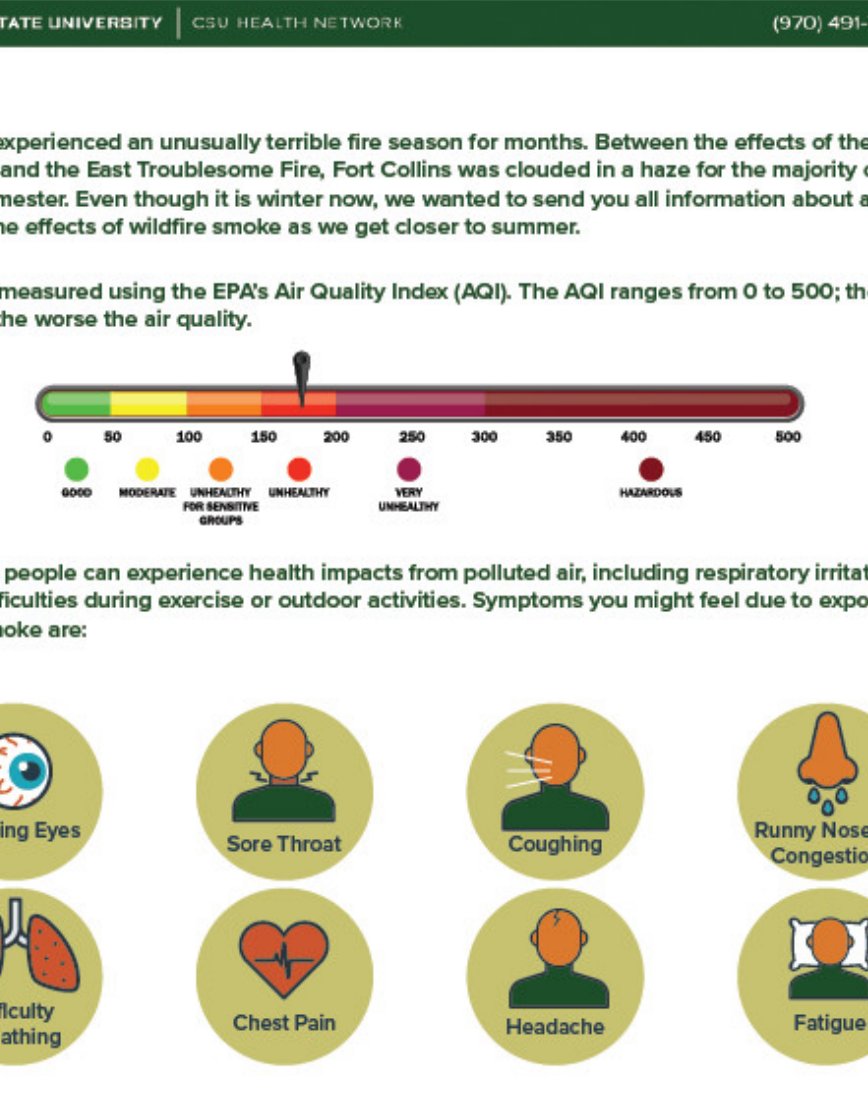
Figure A4. Low-efficacy, visual-based stimuli.